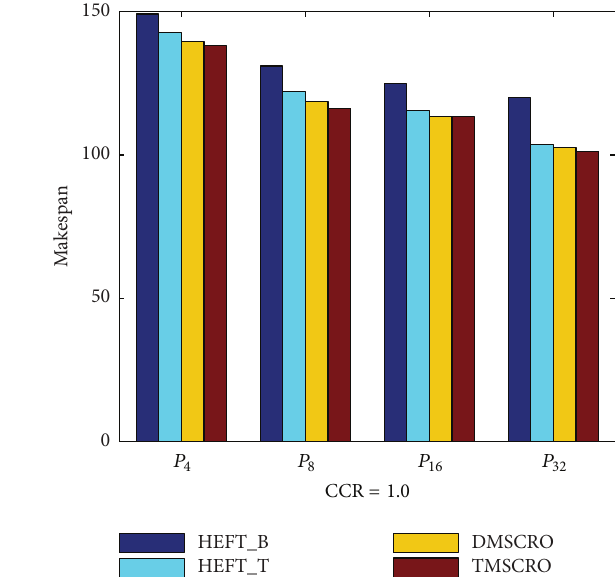
Figure 15: Average makespan for Gaussian elimination.